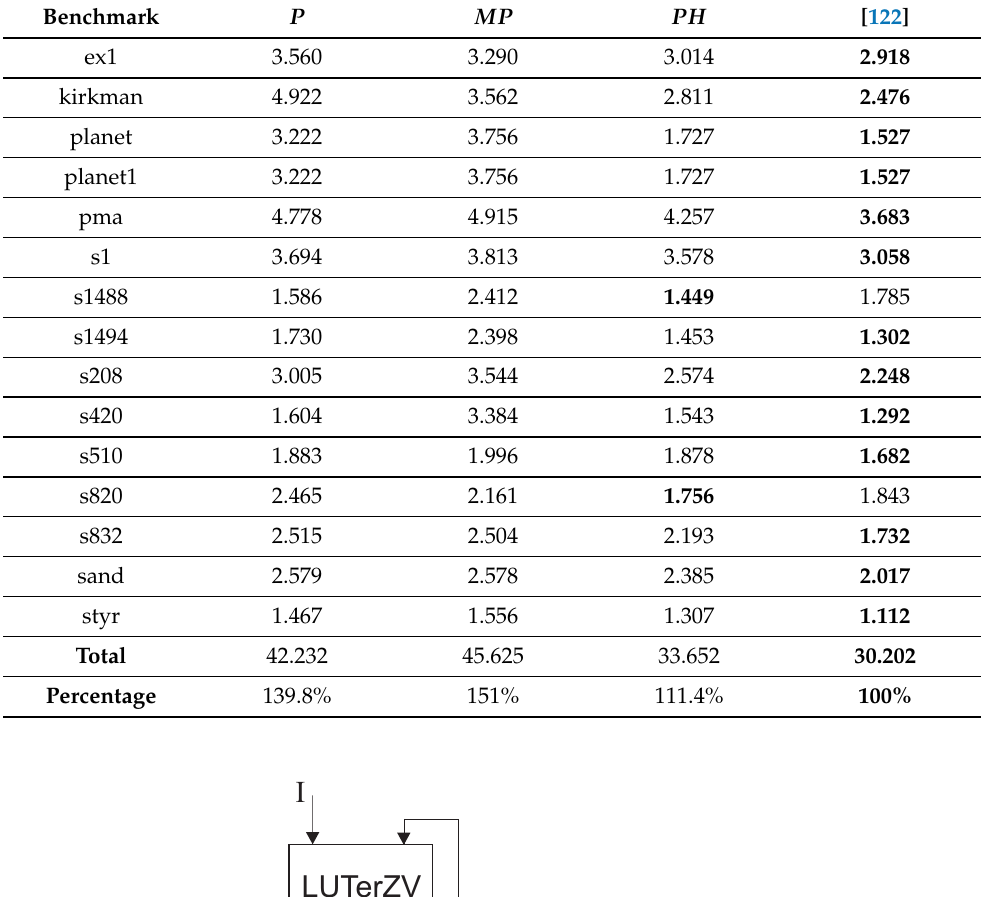
Table 15. Experimental results [122] (the consumed power, Watts).